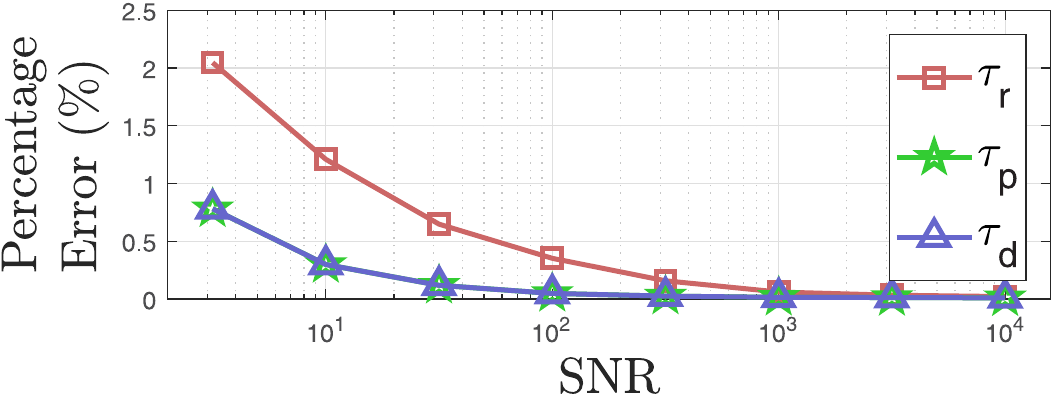
Fig 7. Noise levels vs. estimation accuracy of the model parameters. Red squares, green pentagram, and blue triangles connected with solid lines denote the average percentage errors for the estimated rise times, fast decay times, and slow decay time from simulated data with SNR levels. The SNR is provided with respect to the phasic